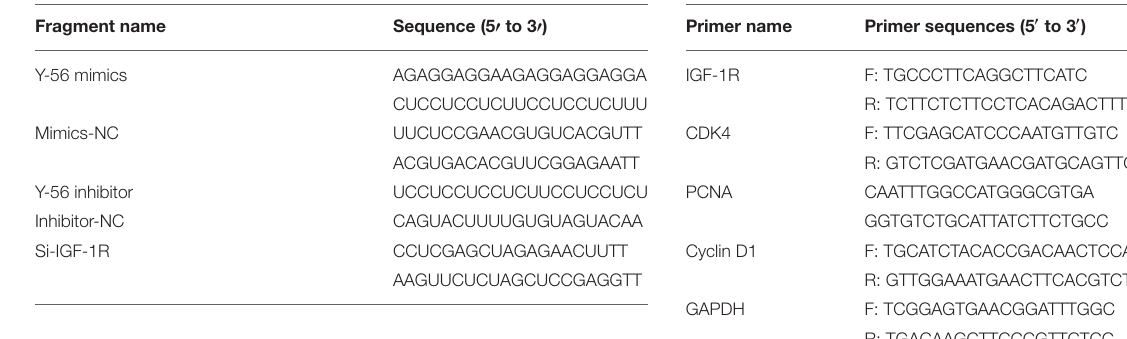
TABLE 1 | Oligonucleotide sequences used in this study. TABLE 2 | Primers used in this